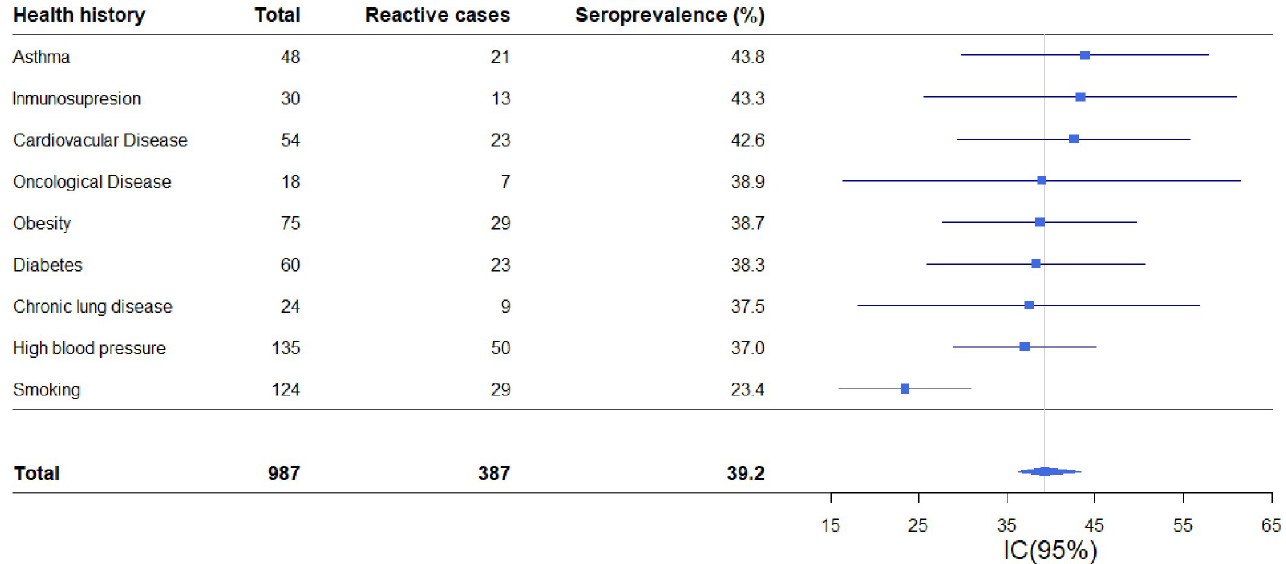
Fig 3. Forest plot of SARS-CoV-2 seroprevalence based on reported health history. Puerto Madryn-Chubut, 2021. N = 987.